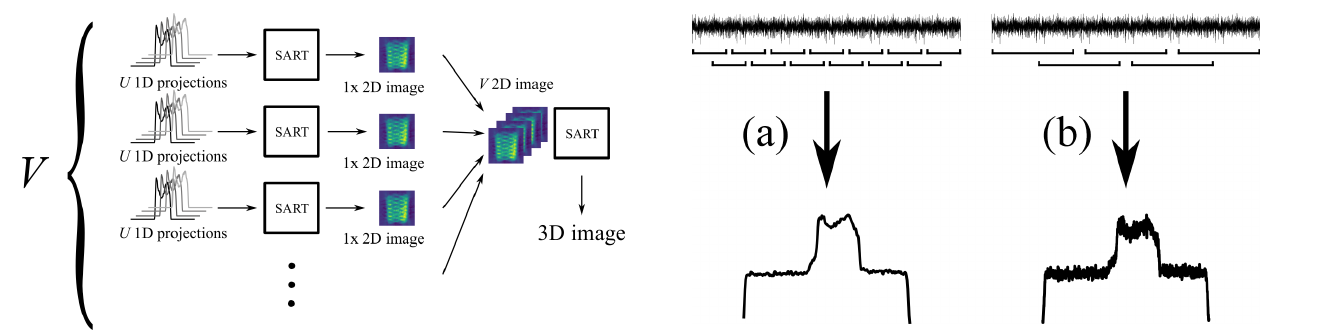
Figure 6. 3D SART reconstruction process. The 3D SART recon- struction algorithm is realized as a two-step process via two succes- sive 2D SART reconstructions. M × N 1D projections are grouped by the same ϕ angle ( V groups in total). Each of the V groups contains U projections with different angles θ . The first SART reconstruction yields V 2D images. Those images represent two- dimensional projections of the sample, all perpendicular to the XY plane. The individual angle between each 2D image and the X axis corresponds to the ϕ angle of the projections the image was created from. Every row (along the Z axis) of every 2D image then rep- resents a 1D projection of a XY slice of the sample (at the same height as the row) around the Z axis. The final 3D image can be reconstructed by using a 2D SART reconstruction on each of those rows individually.